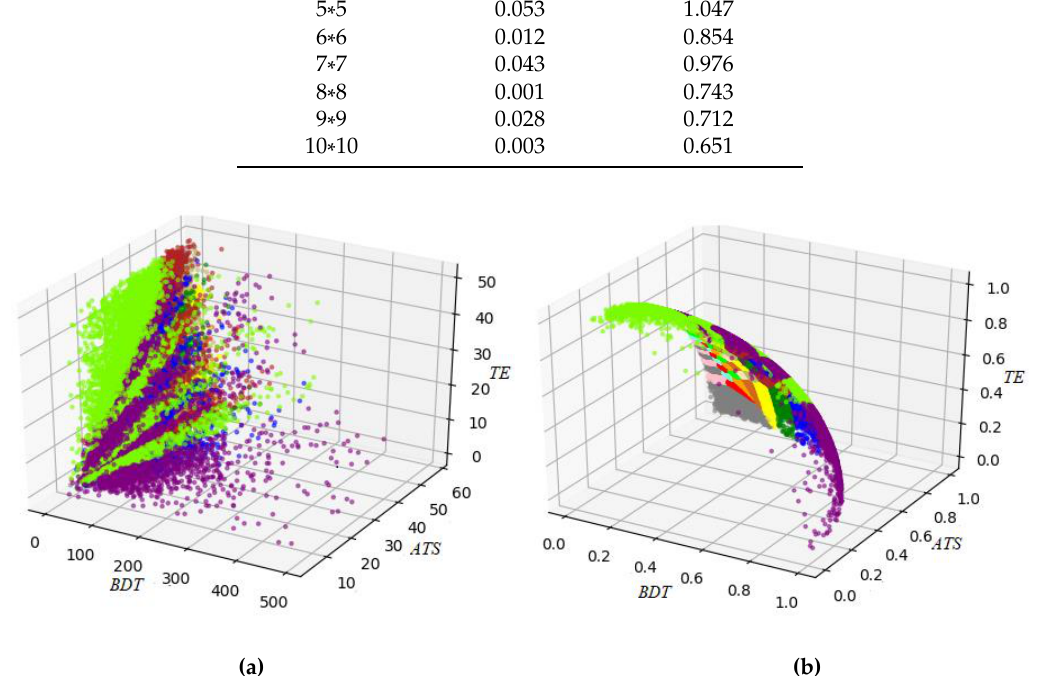
Figure 6. ( a ) Clustering results of three traffic indicators for RSBs. ( b ) The normalized results.